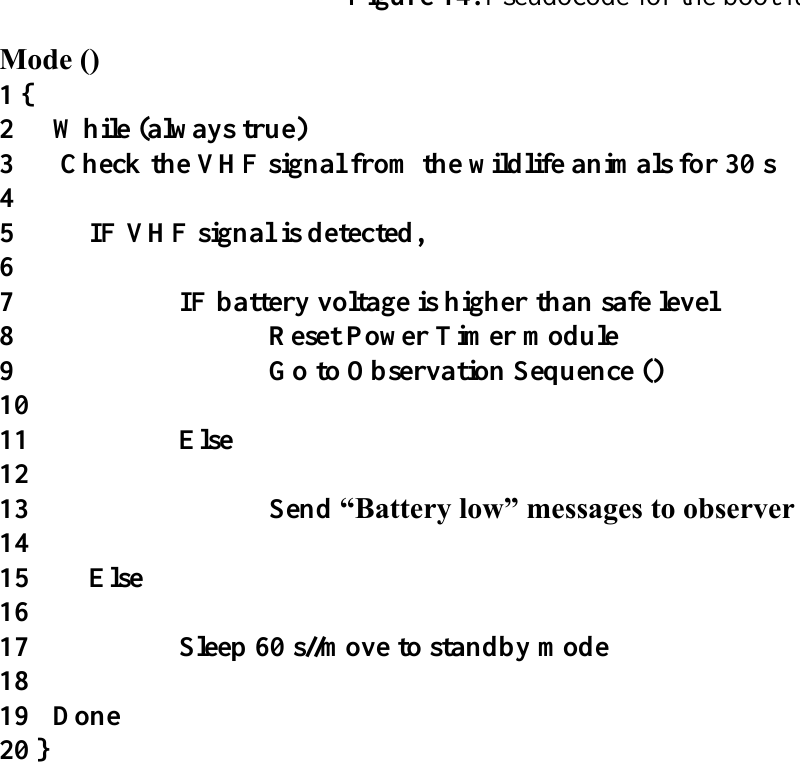
Figure 14. Pseudocode for the boot function.